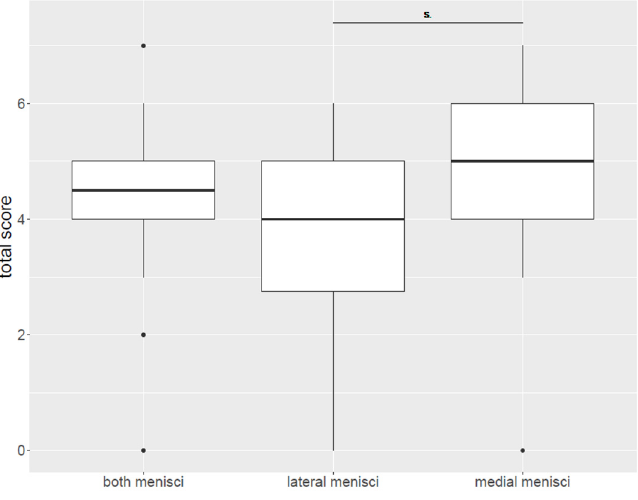
Figure 4. Total histological degeneration score in medial and lateral menisci. There was a significantly